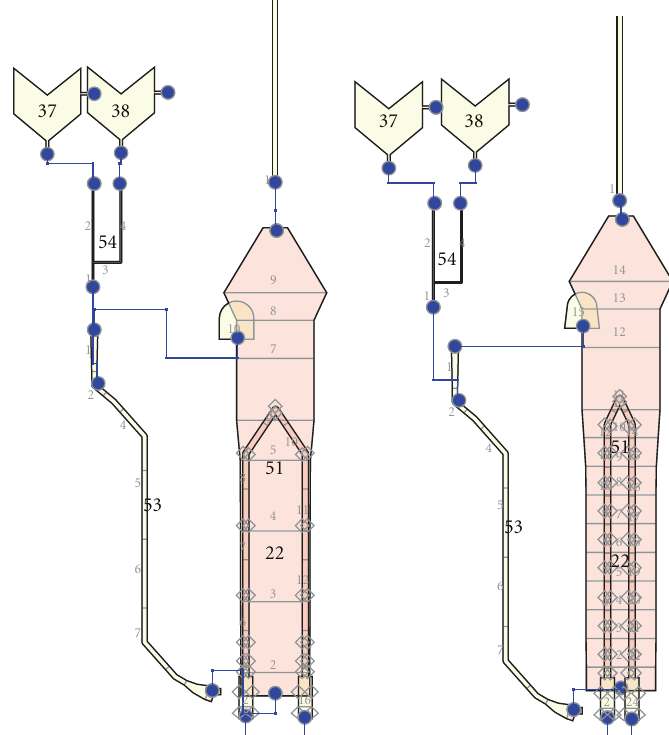
Figure 12: Old and new nodalization of the SG and U-tubes. Modification introduced during the analysis of Test 6-2.